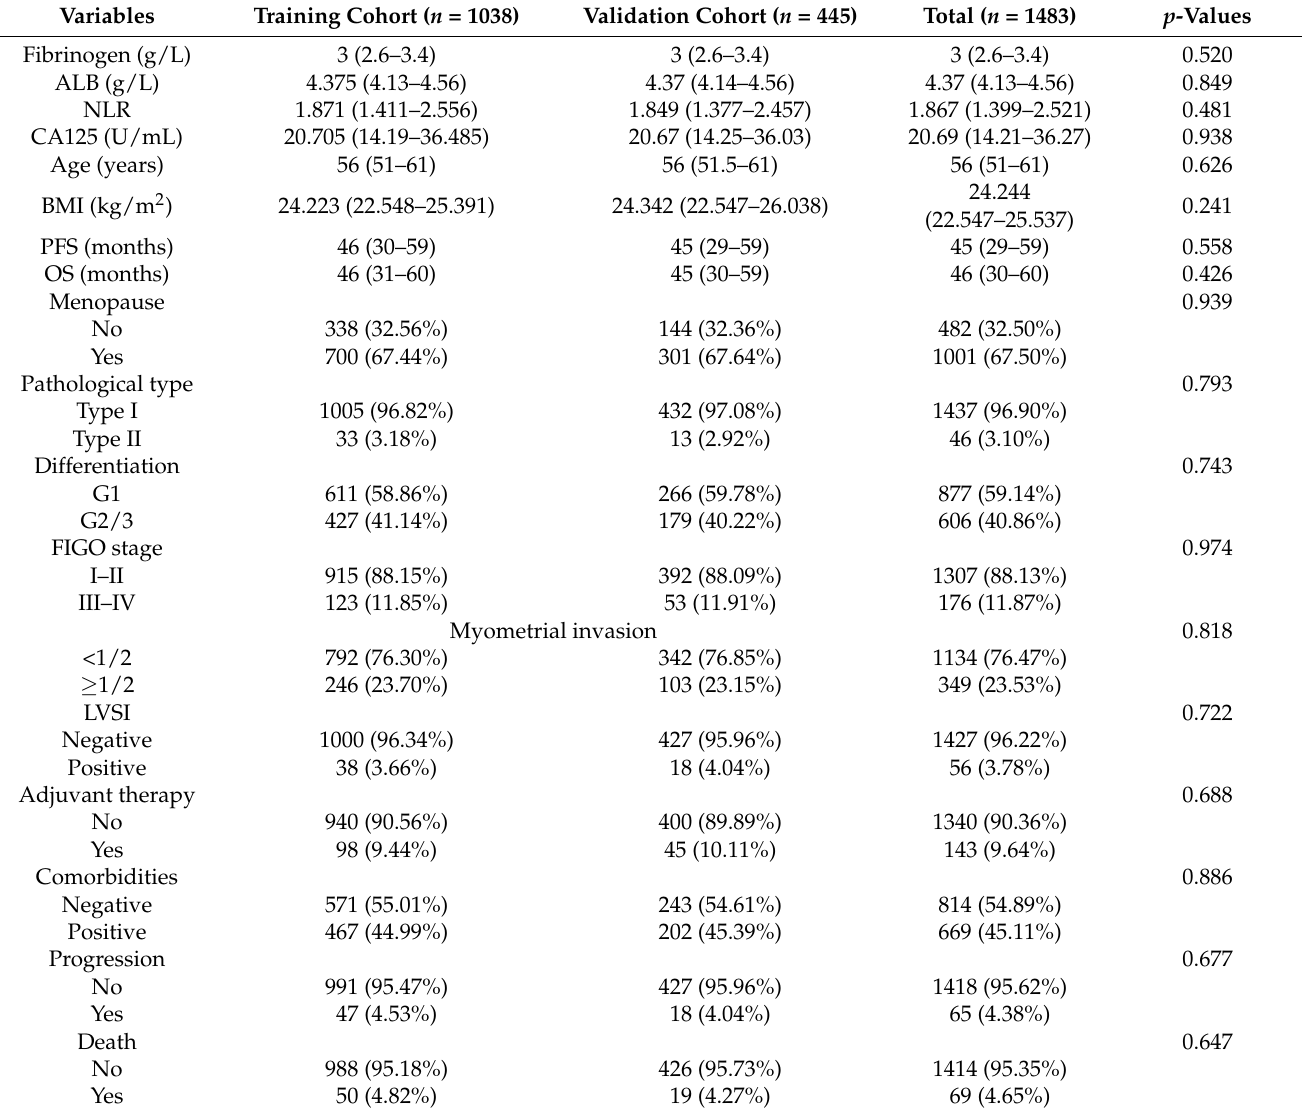
Table 1. Patient biomarkers and characteristics of the training and validation